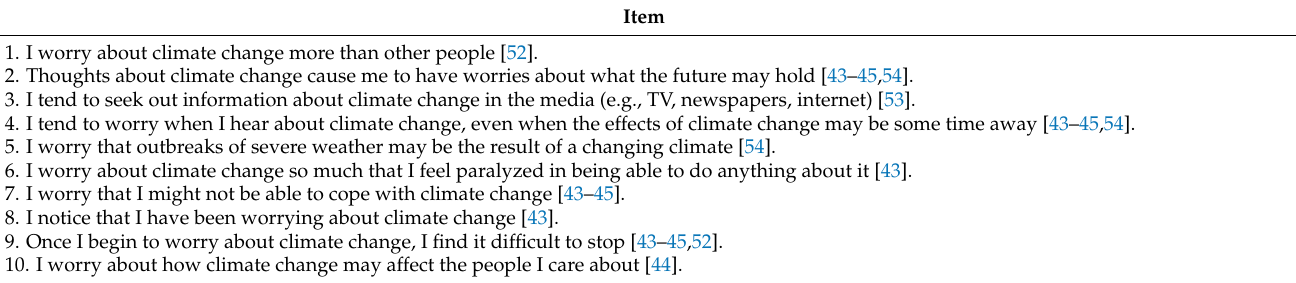
Table 1. Items of the Climate Change Worry